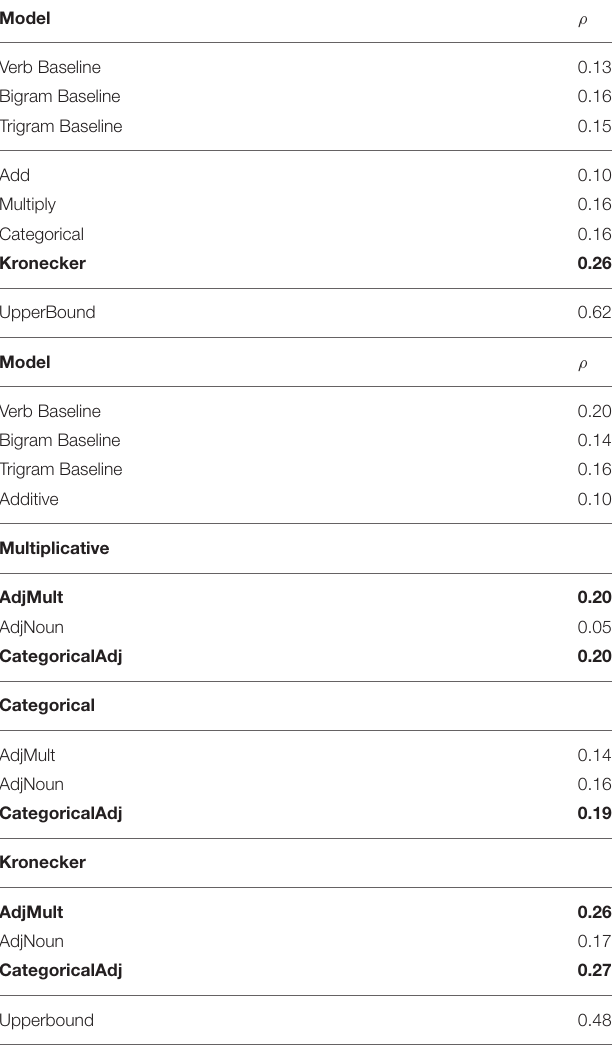
TABLE 4 | Model correlation coefficients with human judgments, cited from Grefenstette and Sadrzadeh [25]. Model